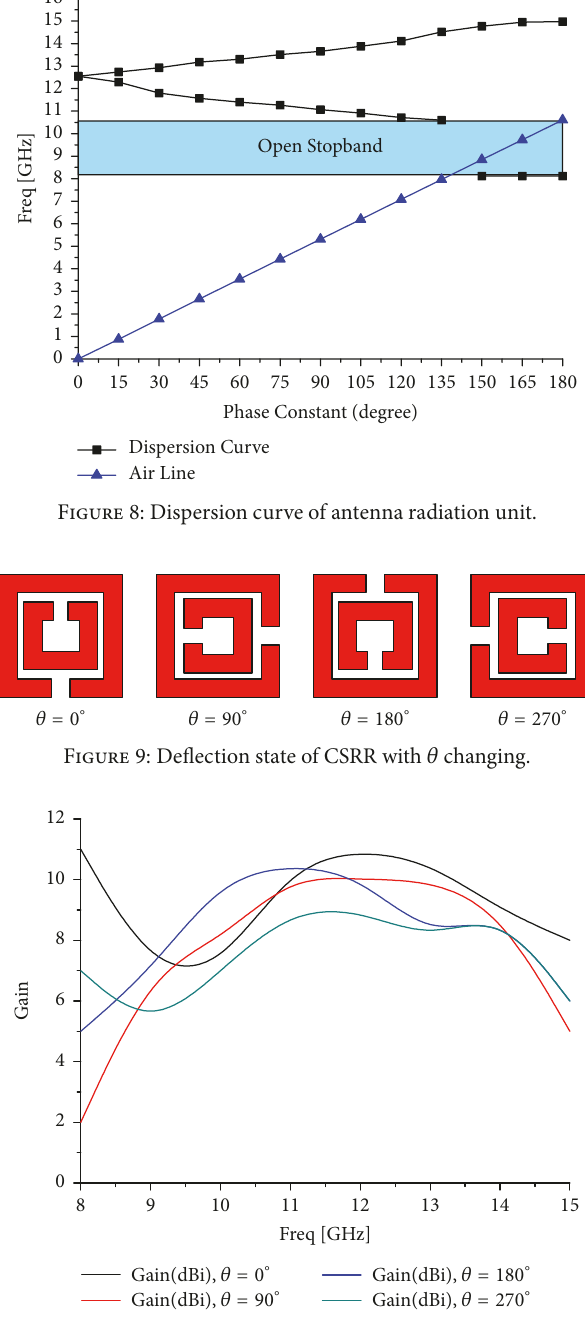
Figure 10: Influence of patch gap orientation on proposed antenna